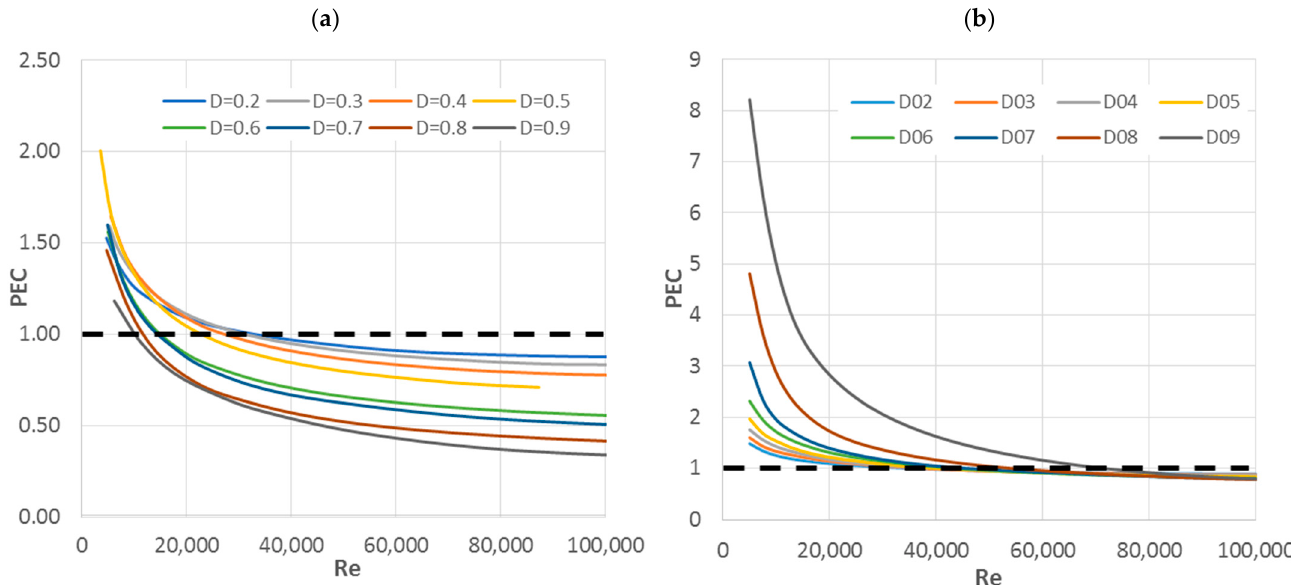
Figure 11. PEC( Re ) characteristics calculated by two methods: ( a ) for the average temperature of the entire pipe section; ( b ) for the average temperature of the annular section.